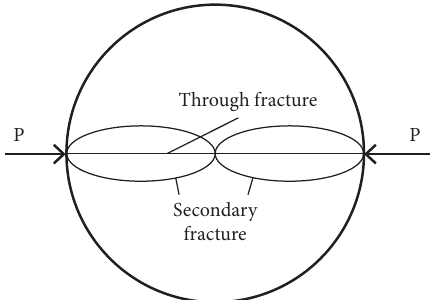
Figure 8: Simplified failure mode of complete disc